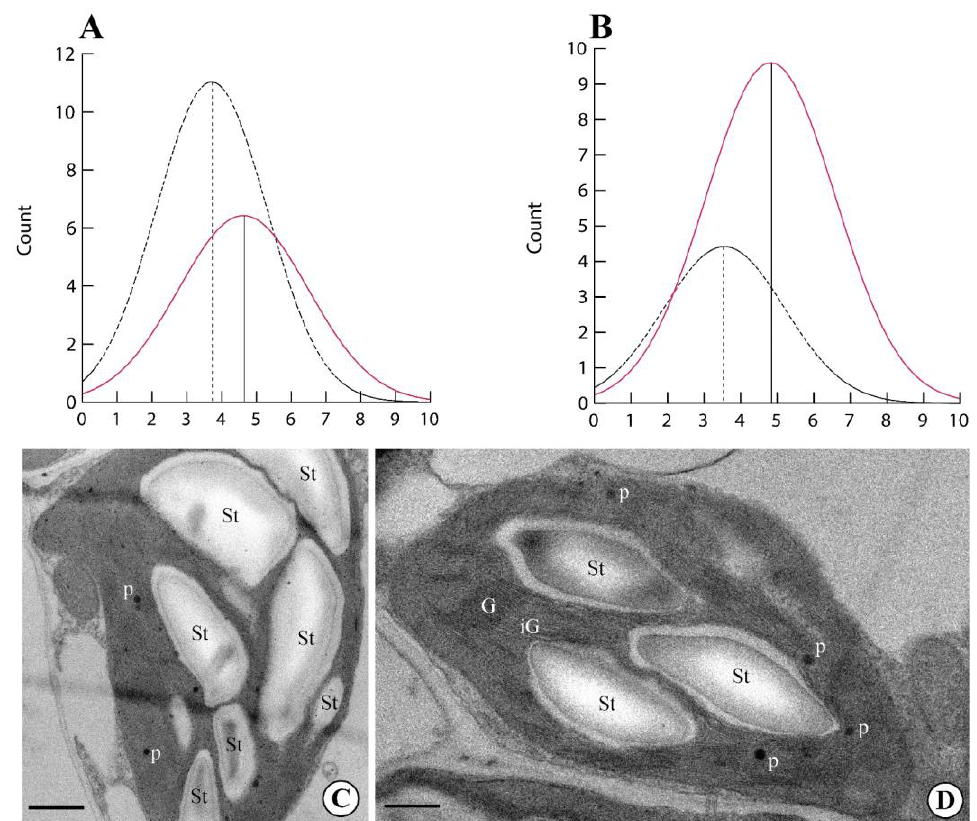
Figure 4. Morphometry of Lima bean chloroplasts in plants exposed to the GMF and NNMF. Density plots of number of starch grains per chloroplast ( A ) and number of plastoglobules per chloroplast ( B ). Dotted line, NNMF. Colored line, GMF. Ultrastructure of Lima bean chloroplasts in plants exposed to the GMF ( C ) and NNMF ( D ). G, granal thylakoids; iG, intergranal thylakoids; St, starch grain; p, plastoglobules. Metric bars: ( C ), 2.80 µ m; ( D ), 3.80 µ m.